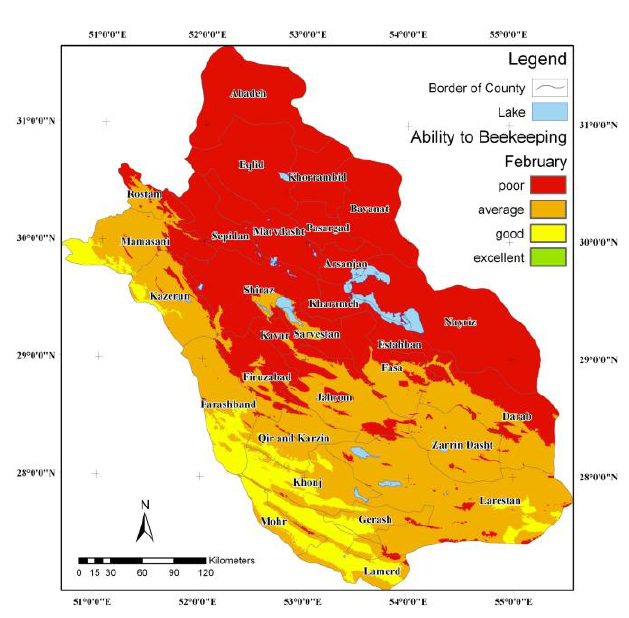
Fig. 11. Suitability of climate conditions for beekeeping in February.